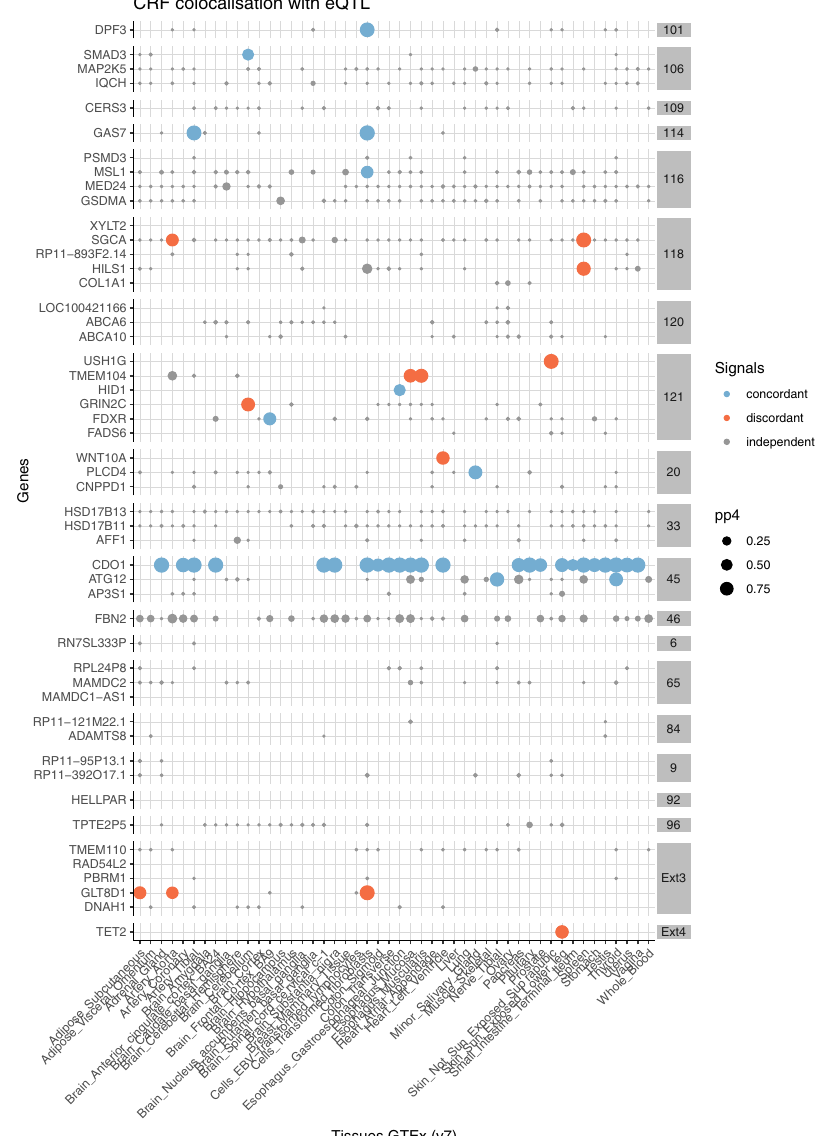
Fig. 2 Colocalisation with GTEx v7 eQTL signals at prioritized corneal resistance factor loci. Genes: candidate target genes based on GTEx eQTL look-up for prioritized candidate causal variants at CRF loci (grey box). Each dot denotes signi fi cant association signals for both CRF and GTEx v7 GWAS, colour- coded as independent (grey) or identical (blue if CRF increasing allele increases gene expression, red if it decreases it). The dot size is proportional to the probability of a colocalisation (pp4); pp4 > 0.75 denotes strong evidence in favour of